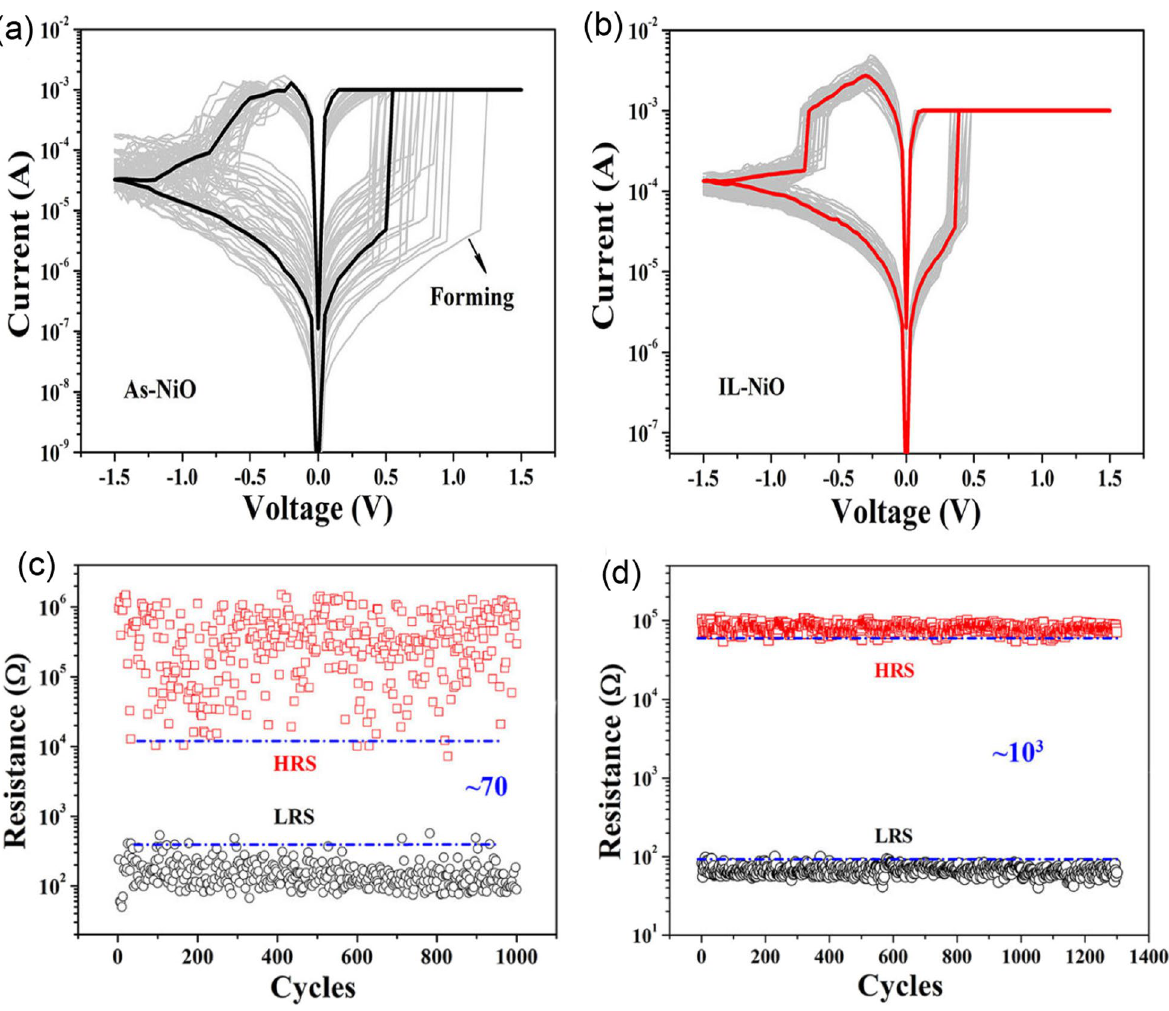
Fig. 18 Characteristics I–V curves and endurance performance of the NiO-based RRAM device. a As-deposited NiO-based device I–V curves. b I–V curves of the IL pre-treated NiO-based RRAM device. c Endurance properties of the as-deposited NiO-based RRAM device. d Endur- ance properties of the IL pre-treated NiO-based RRAM device